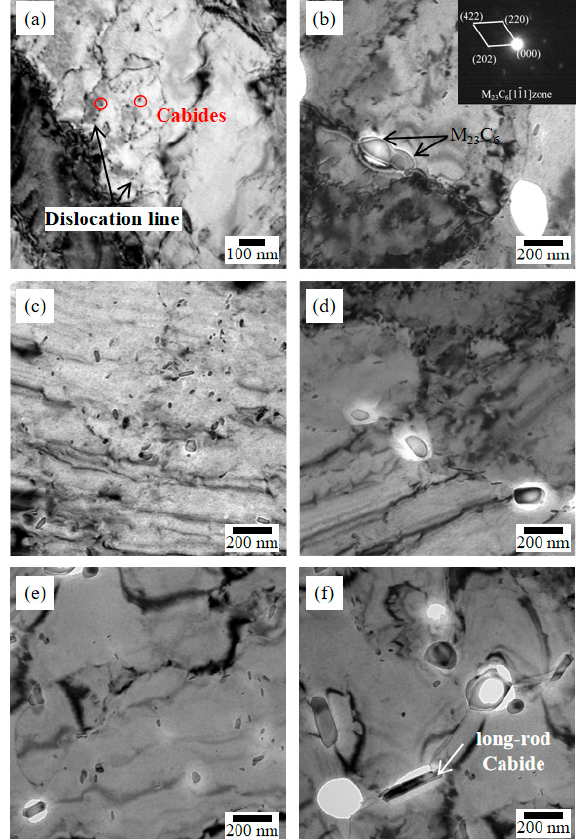
Figure 13. TEM images showing ( a ) many carbides forming on the dislocation lines, ( b ) the large- sized carbides at the grain boundary in the necking area of the 450 °C tensile samples, ( c , d ) carbides in the necking area of the 500 °C tensile samples, and ( e , f ) carbides in necking area of the 550 °C tensile samples. All samples were subjected to Max.SPWHT.